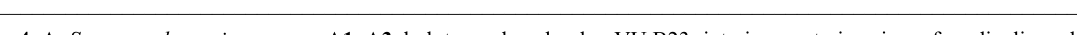
Fig. 4. A , Sampo suduvensis sp. nov.: A1 – A3 , holotype, dorsal valve VU B23, interior, posterior view of cardinalia and view of bema; Kalvarija-2 drill core, depth 900.3 m, Jakšiai Fm., Rakvere Stage(?). B , Sampo hiiuensis Öpik, interior of dorsal valve GIT 675-340; Kõrgessaare, Hiiumaa Island, Estonia, Vormsi Stage, Upper Ordovician. C – I , Sampo suduvensis sp.